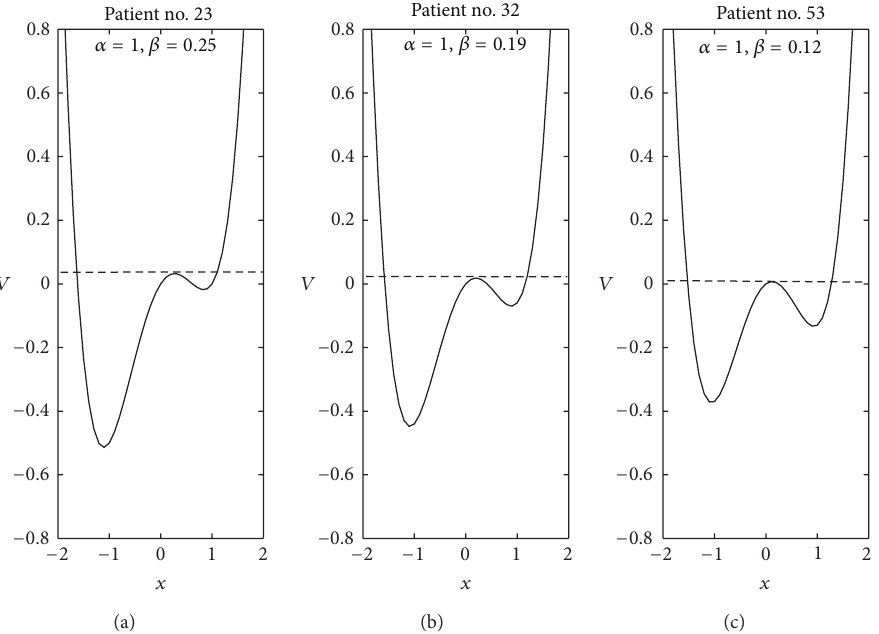
Figure 8: Potential 𝑉 for three sample patients. As an example, the three patients in Figure 2 are considered (no. 23, no. 32 and no. 53 in our dataset) and the mean duration of their relapses and remissions estimated. These values are then used to compute the ratio of the potential barriers Δ𝑉 1 /Δ𝑉 2 according to (7) (for the estimates see Model Solutions). The potential 𝑉 for each patient ((a)–(c)) is given by (3) setting 𝛼 = 1 and choosing 𝛽 so that the two wells are asymmetric in the predetermined ratio. In particular, it is found (a) 𝛽 = 0.25, (b) 𝛽 = 0.19, and (c) 𝛽 = 0.12. Dashed line denotes the upper bound of the potential